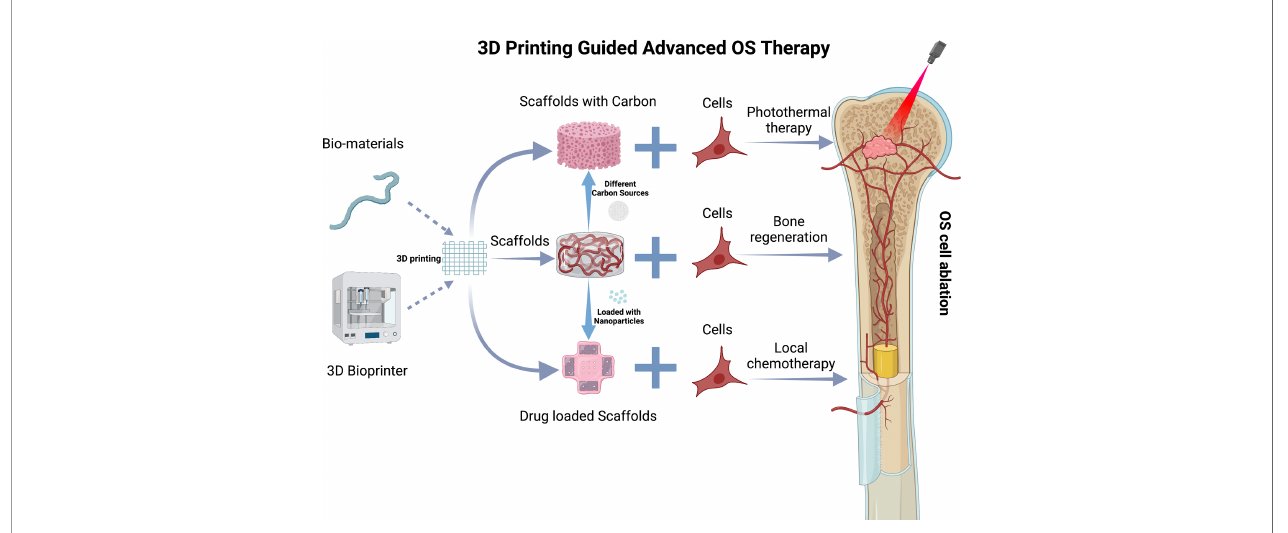
FIGURE 4 | 3D Printing guided advanced OS therapy. 3D printing scaffold and various types of carbon sources or nanocariers that may be incorporated. The nanocarriers and carbon sources are included in a 3D printed scaffold. The scaffold is then implanted into the critical defect site in the tibial due to OS resection to present bone regeneration, photothermal therapy, and local chemo release. This fi gure was created with